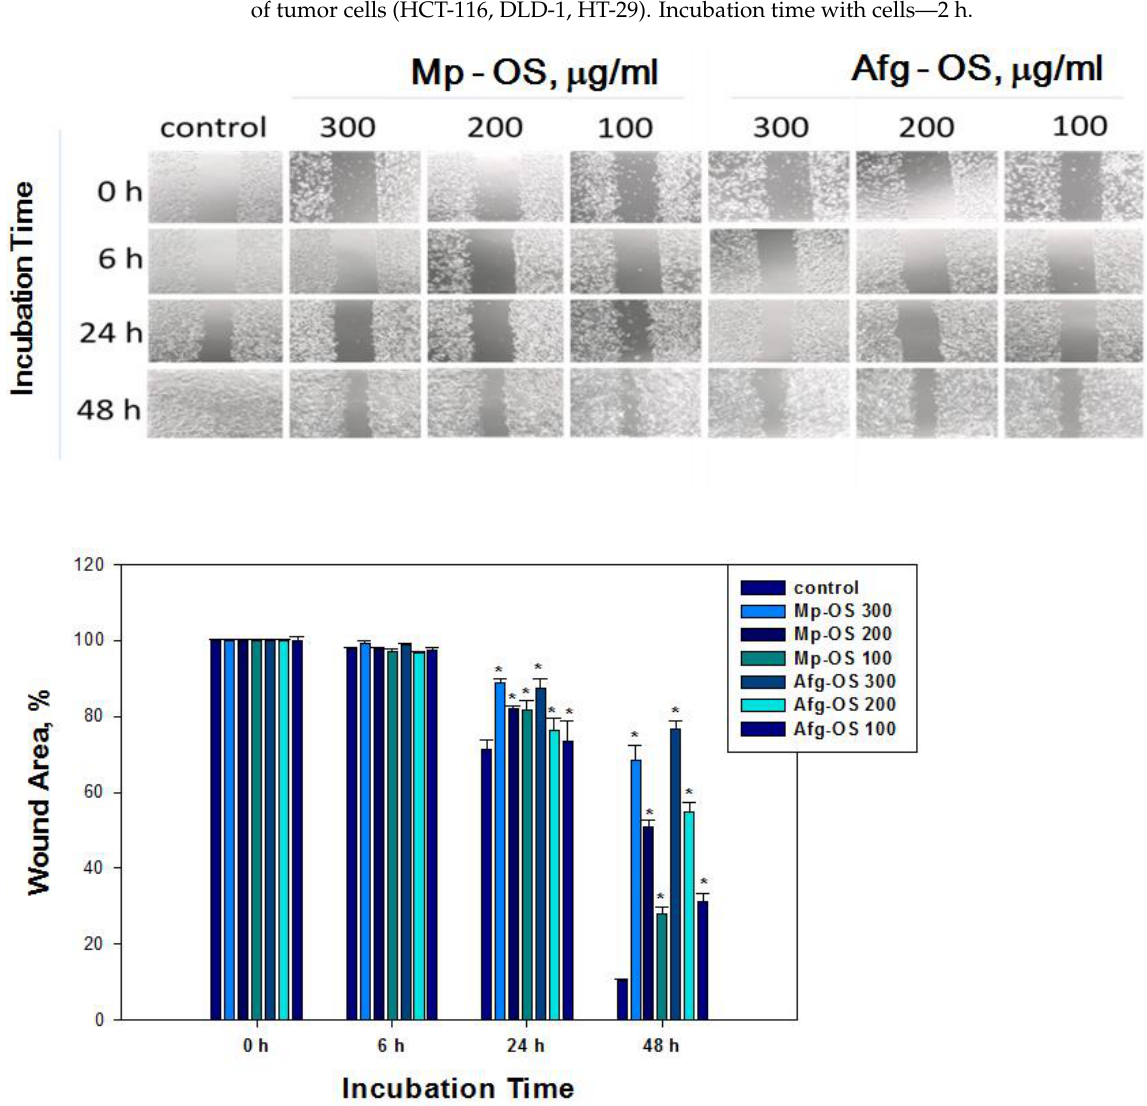
Figure 3. Cell migration into wound areas was observed under EVOS XL Core microscope at 0, 6, 24 and 48 h. ImageJ 1.52 software was used to analyze cell migration into wound areas. Data are presented as means ± SEM. * p value < 0.05 considered